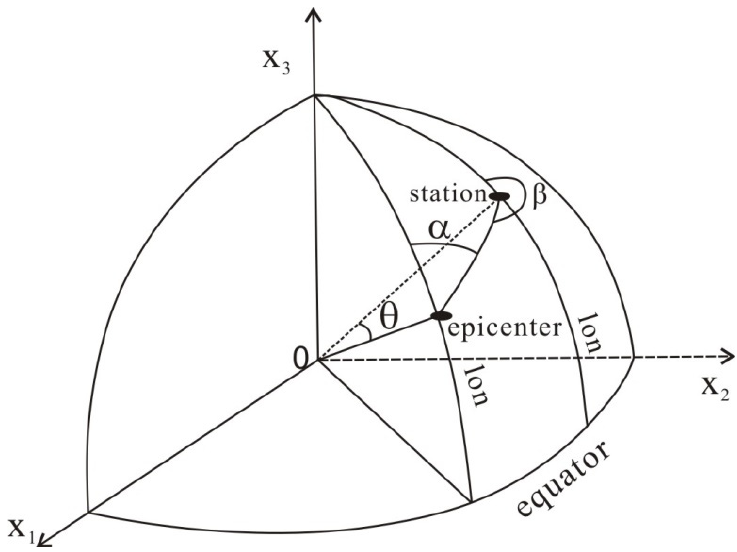
Figure 1. Diagram of azimuthal correction.